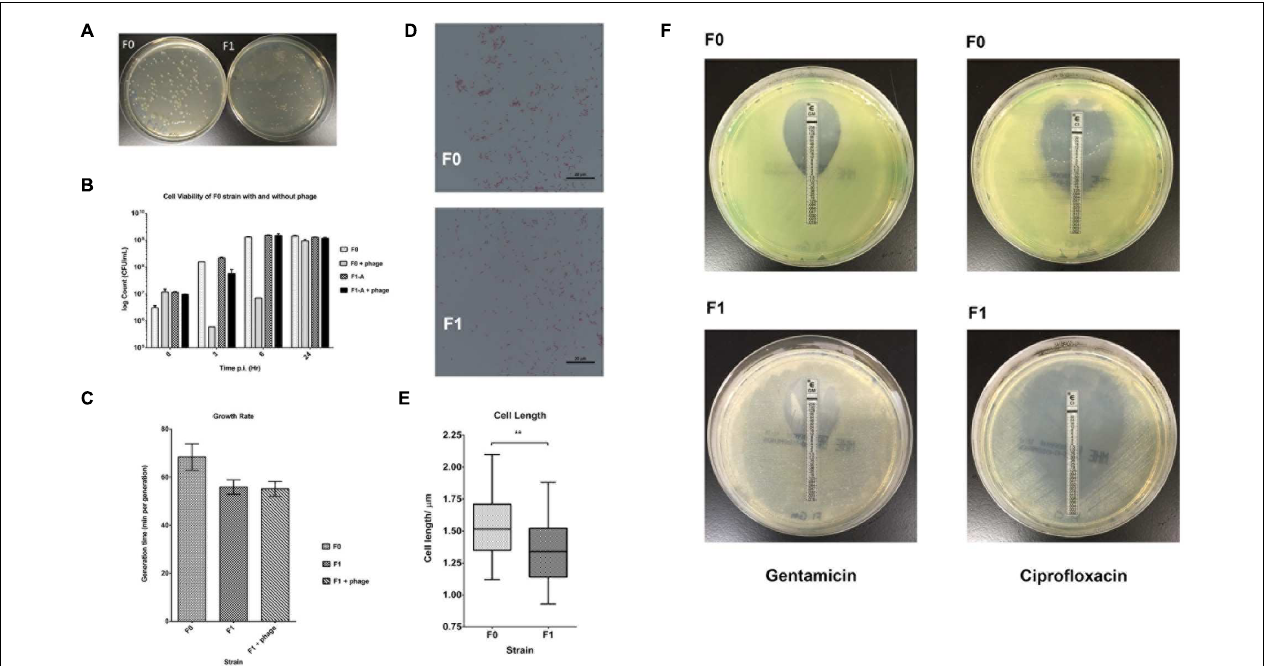
FIGURE 1 | Morphology and Cell Viability. (A) Bacteria was plated on agar plates and incubated for 24 h at 37 ◦ C; left- F0 (wt); right- F1 (SCV) . (B) Bacteria count at 0, 3, 6, 24 h post infection (p.i.) for F0 and F1 strains. (C) Generation times (time taken for the doubling of population) for F0 and F1 strains, a total of three biological replicates were carried out. (D) Morphologies of gram-stained F0 and F1 strains, viewed under a 100x objective. (E) Distribution of cell length of 40 replicates each for F0 and F1 strains; Mann–Whitney test. F1 cells are significantly smaller than F0 cells. (F) Antibiotic susceptibility of F0 and F1 strains to gentamicin (left panels) and ciprofloxacin (right panels). ∗ p < 0.05, ∗∗ p < 0.005, ∗∗∗ p < 0.0005.